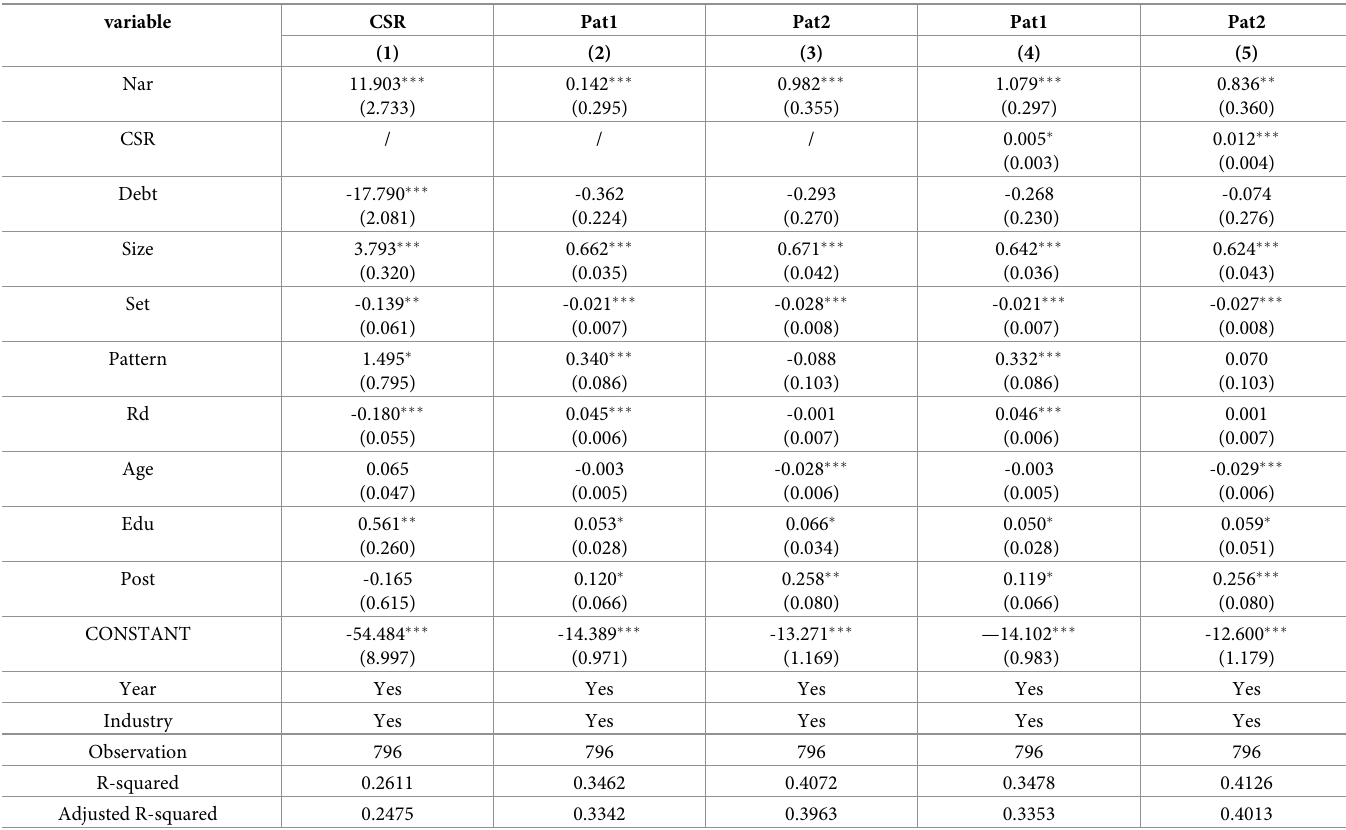
Table 10. One period of lag—a robustness test of the mediation effect.